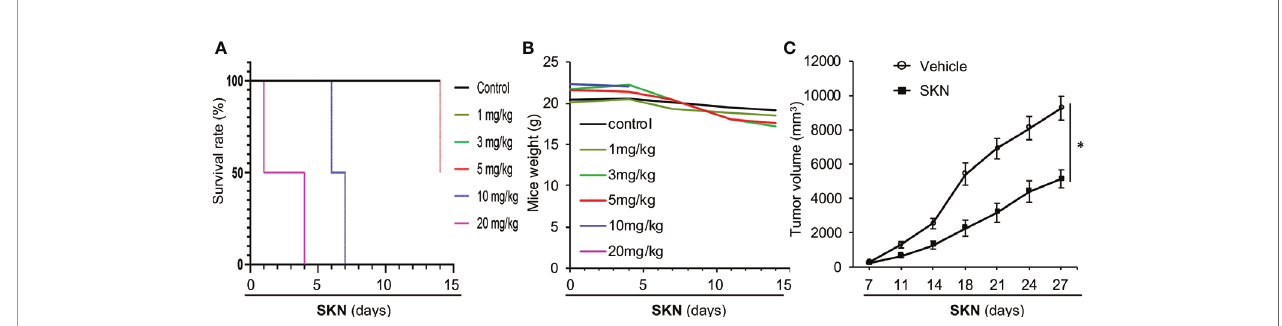
FIGURE 8 | Mouse studies of Shikonin. (A) 5 – 6 week old nude mice (n = 2) were injected with vehicle control or 1, 3, 5, 10 or 20 mg/kg Shikonin i.p. twice a week for 2 weeks, and mouse survival was plotted by the Kaplen – Mier plotter. (B) Body weight of mice in (A) was recorded and plotted over time. (C) For nude mice tumor study, 5 * 10 6 A549 cells were inoculated into nude mice subcutaneously. When the tumor reached around 100 mm 3 in size, the mice were treated with 2 mg/kg of Shikonin i.p. twice a week for 3 weeks. Tumor volumes were measured during this time period. Data represent mean and standard error of tumor volume from six mice per group. *P